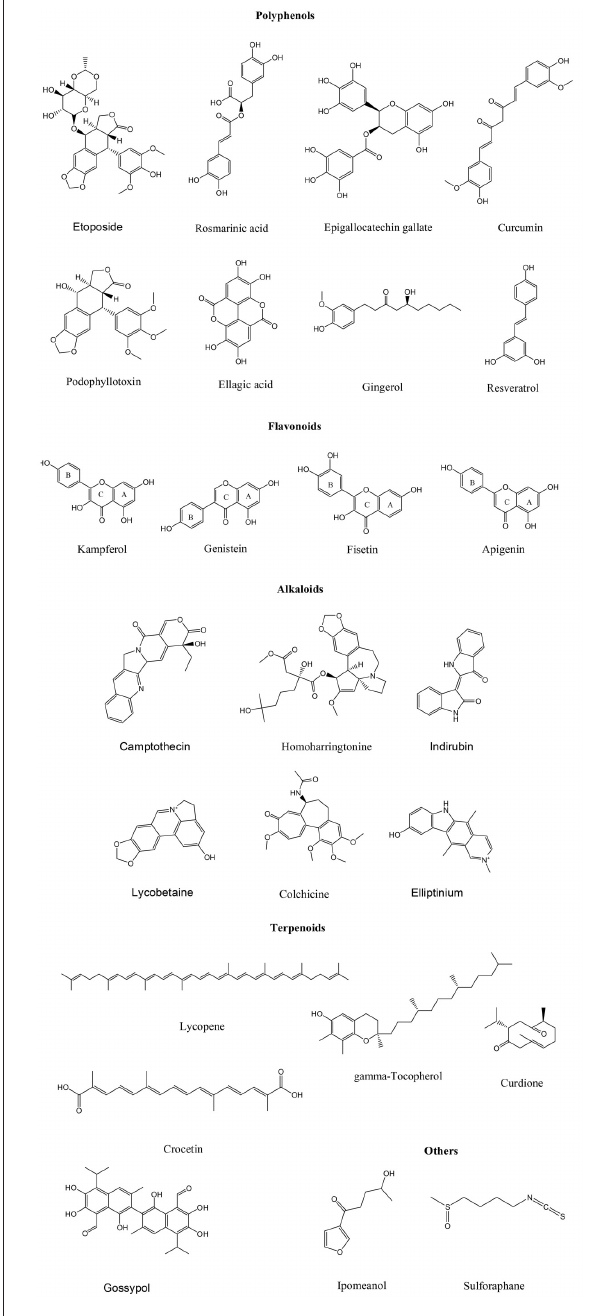
FIGURE 1 | Chemical structures of some anticancer